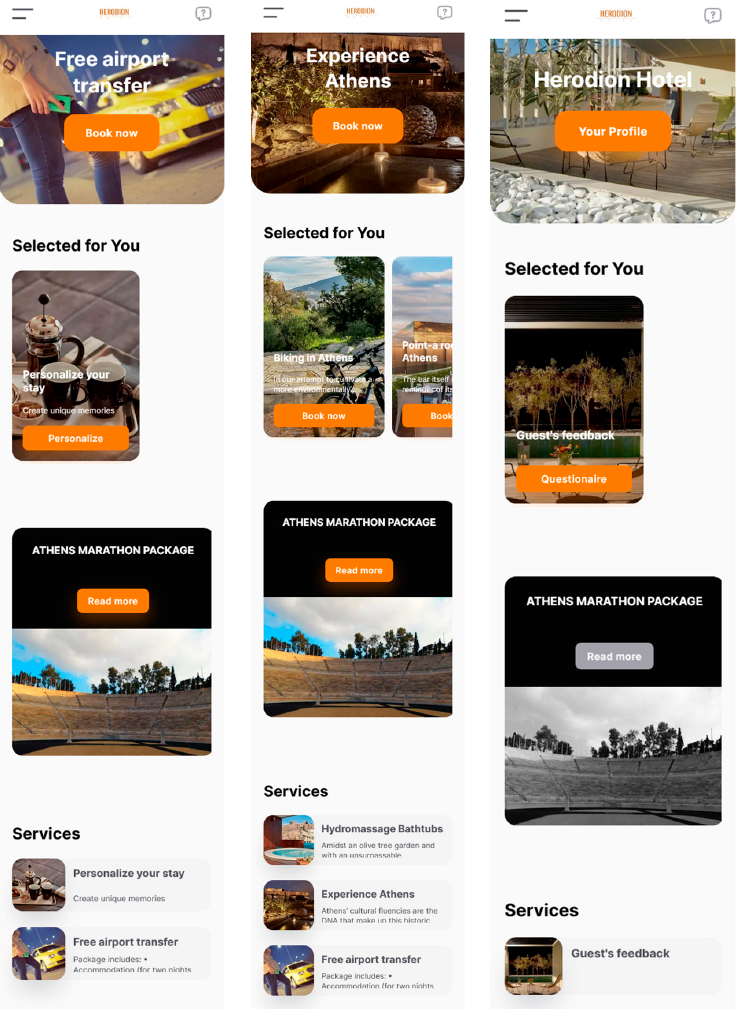
Figure 5. Stages of guest experience in the hotel industry: before arrival ( left ), during the stay ( center ), and after departure ( right ).